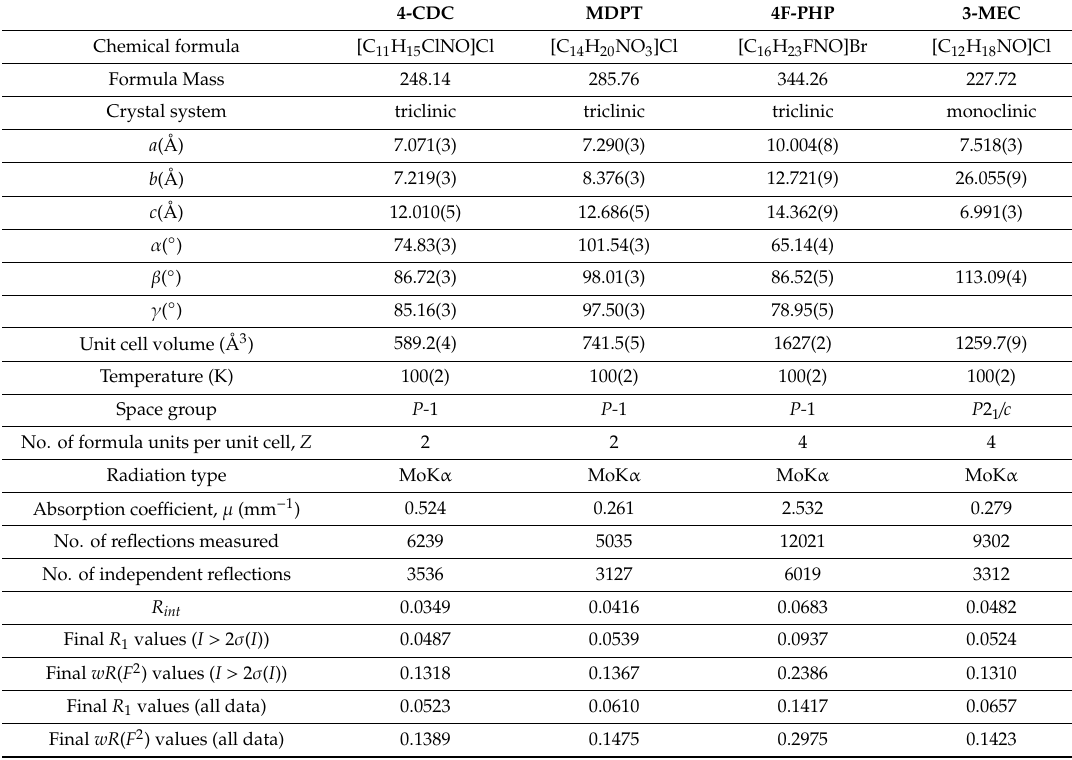
Table 1. Crystal data and structure refinement for Compounds 1 – 4